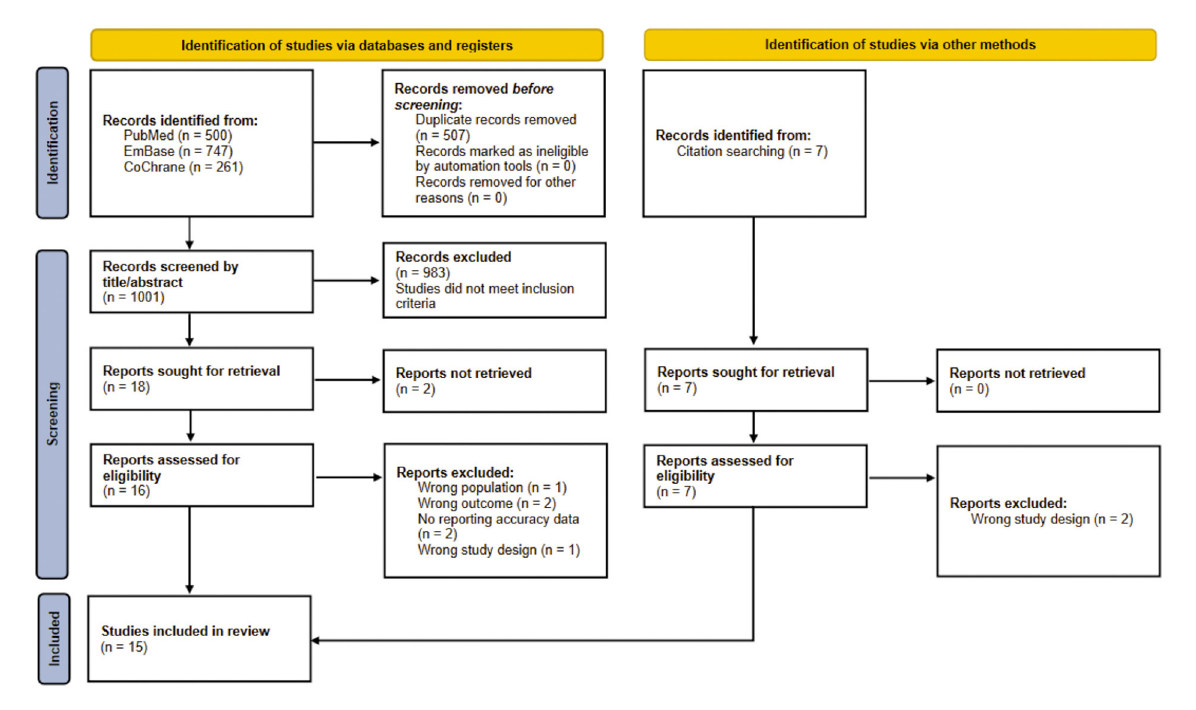
FIGURE2 Study selection flow